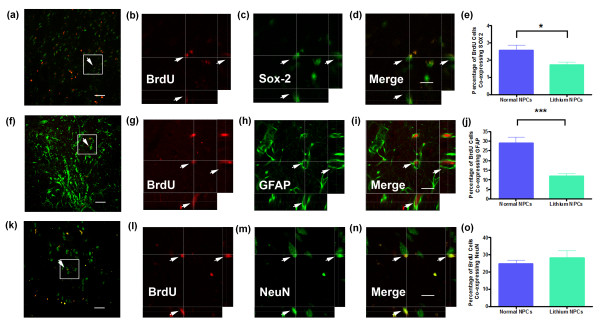
In vitro priming of SVZ-derived adult neural progenitor cells with lithium chloride reduces gliogenesis 12 weeks after transplantation. Representative confocal micrographs in low power and in high power with orthogonal projections of BrdU-labeled lithium chloride-primed adult neural progenitor cells co-expressing (a through d) the immature neural progenitor cell marker SOX-2, (f through i) the astrocytic marker GFAP, and (k through n) the mature neuronal marker NeuN. Graphs comparing the proportion of transplanted BrdU-labeled cells co-expressing (e) SOX2, (j) GFAP, or (o) NeuN labeling 12 weeks after transplantation. Scale bar, 40 μm (a, f, and k) and 20 μm (B-D, G-I, L-N). *P < 0.05; ***P < 0.001.